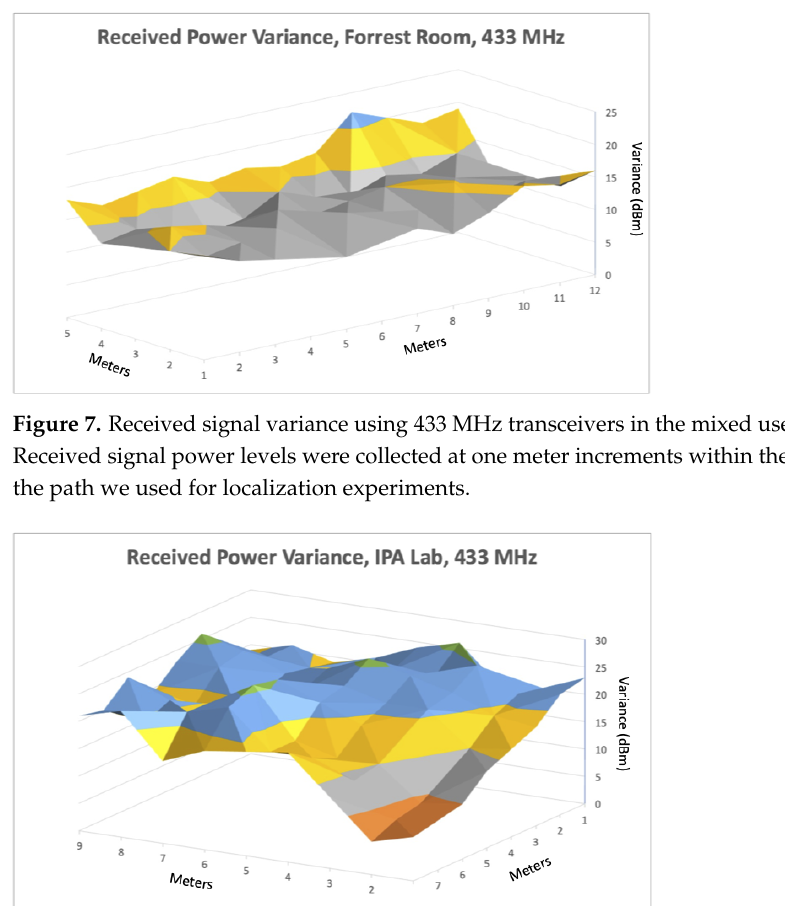
Figure 6. Received signal variance using 433 MHz transceivers in the open Gym space. Received signal power levels were collected at one meter increments within the space that contained the path we used for localization experiments.